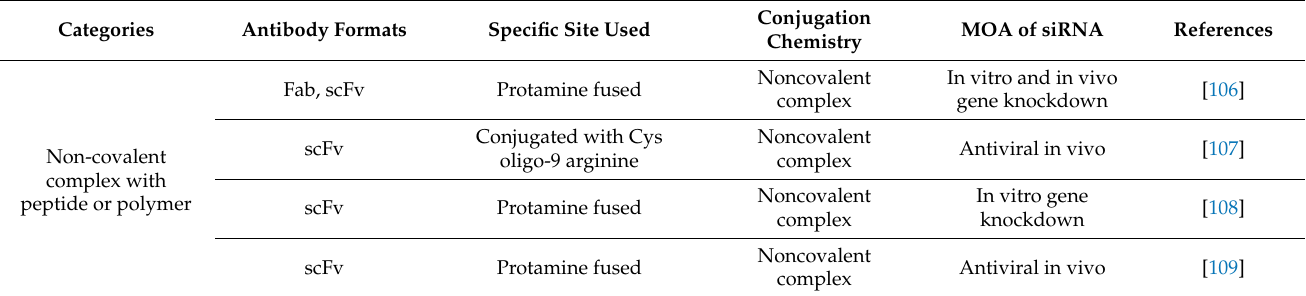
Table 4. Site-specific antibody conjugations with